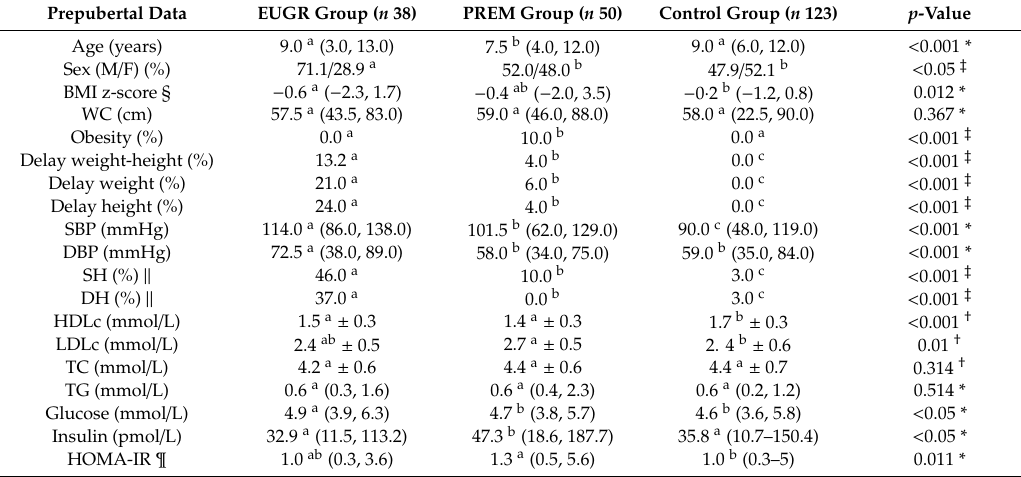
Table 2. Demographic and anthropometric parameters, blood pressure and biochemical markers in prepubertal children with a history of prematurity and extrauterine growth restriction (EUGR group), those with prematurity without EUGR (PREM group) and healthy children (Control